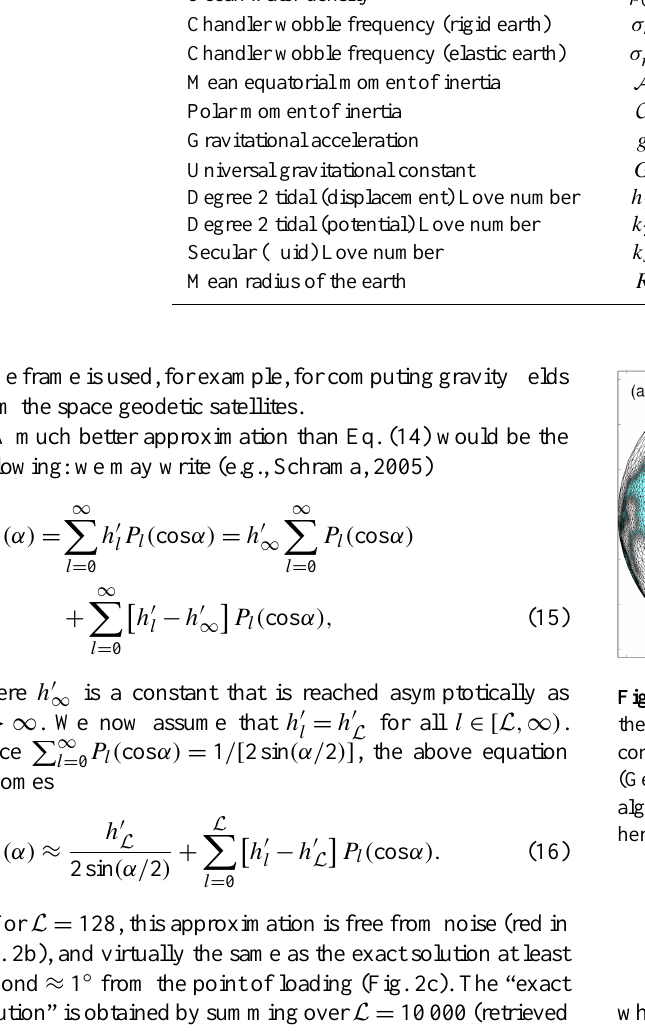
Table 1. Constants and parameters used in this study. Solid-earth parameters are taken from Lambeck (1980). Constant/parameter Symbol Value Unit Mean rotational velocity of the earth (cid:127) Average density of the earth Ice density Ocean water density ρ O Chandler wobble frequency (rigid earth) σ r Chandler wobble frequency (elastic earth)